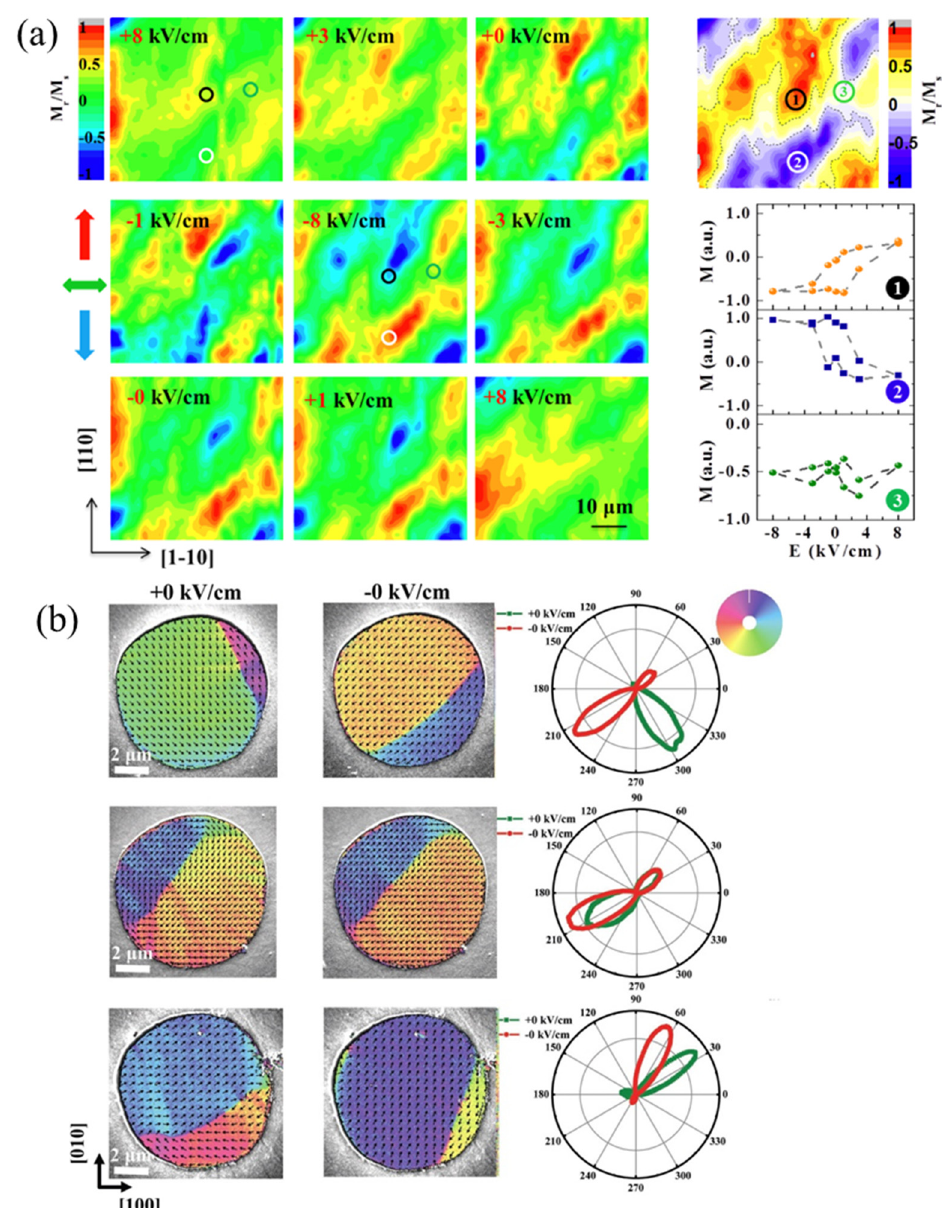
view of the rhombohedral lattice deformation in the 109° domain switching. ( e ) The corresponding changes of the FE polarization direction for the three types of FE domain switching in each rhombohedral lattice. Reproduced with permis- sion from reference [69].